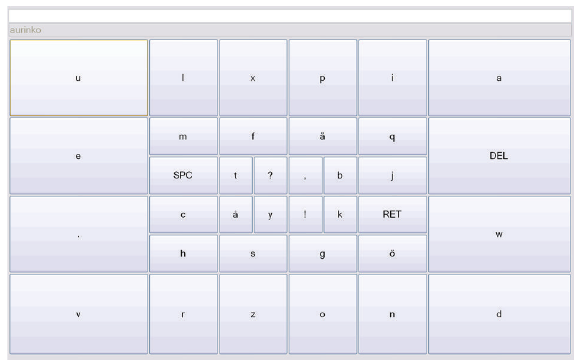
Figure 4: Layout